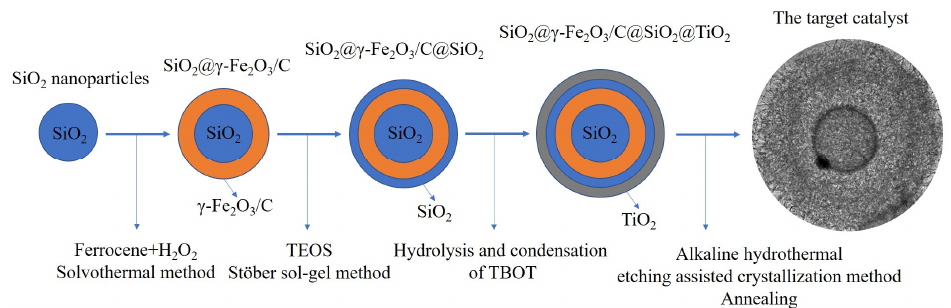
Figure 1. Catalyst synthesis process.